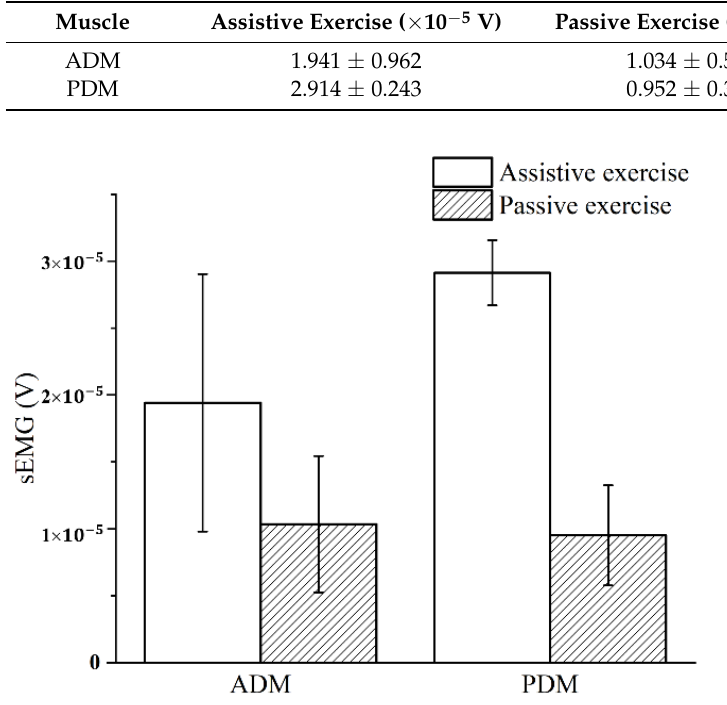
Figure 15. RMS of two muscles in exercise